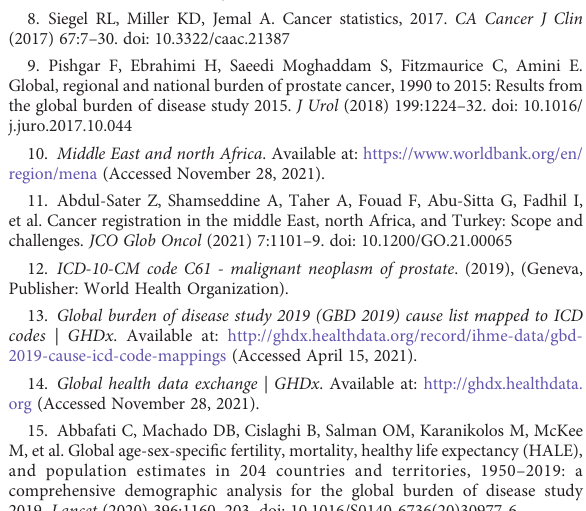
SUPPLEMENTARY TABLE 1 Data sources of GBD study 2019 for prostate cancer in North Africa and Middle East. SUPPLEMENTARY TABLE 2 All-ages incidence, prevalence and death due to prostate cancer in 1990 and 2019 and their percent changes. SUPPLEMENTARY TABLE 3 Incidence trends of prostate cancer between 1990 and 2019 among countries in North Africa and Middle East. SUPPLEMENTARY TABLE 4 All-ages YLLs, YLDs, and DALYs due to prostate cancer in 1990 and 2019 and their percent changes. SUPPLEMENTARY TABLE 5 All-ages YLLs, YLDs, and DALYs of prostate cancer attributable tosmoking in 1990 and 2019 and their percent changes. SUPPLEMENTARY FIGURE 1 Time trends of age-standardized and all-ages rates of incidence, prevalence, deaths, and DALYs due to prostate cancer among countries in North Africa and Middle East in 1990 and 2019. SUPPLEMENTARY FIGURE 2 Time trends of age-standardized and all-ages rates of incidence, prevalence, deaths, and DALYs due to prostate cancer in North Africa and Middle East in 1990 and 2019. SUPPLEMENTARY FIGURE 3 Rates of incidence, prevalence, deaths, YLLs, YLDs, and DALYs due to prostatecancer amongagegroupsincountriesinNorthAfricaandMiddle East in 1990 and 2019. SUPPLEMENTARY FIGURE 4 Age-standardized rates of incidence (A) , prevalence (B) , deaths (C) , and DALYs (D) due to prostate cancer among countries in North Africa and Middle East disaggregated by